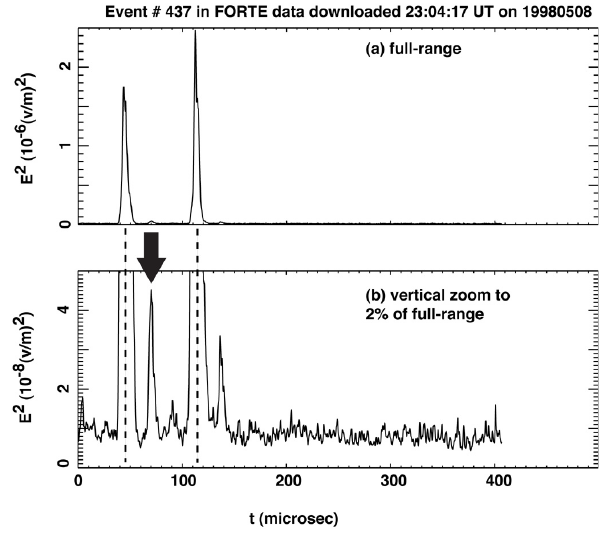
Fig. 10. An autonomously triggered TATR record that is coinci- dent with autonomously triggered PDD. (a) Squared electric field vs. time, averaged over a 1.5µs sliding window. (b) Squared elec- tric field vs. time, clipped to 2% of full range. Vertical dashed lines mark the TIPP main pulse and echo. Arrow marks a “secondary- breakdown pulse”. Same TATR record as shown below in Fig.